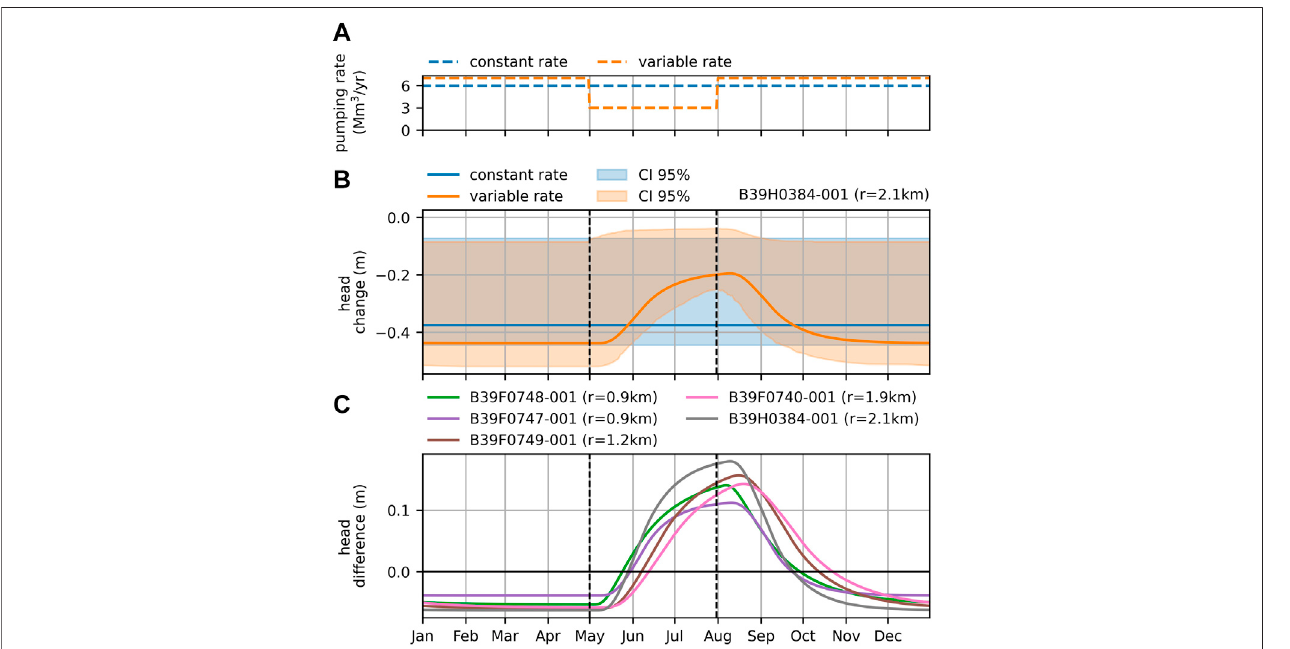
FIGURE 9 | Comparison of the effect of two pumping regimes (A) on the calculated drawdowns for well B39H0384 (B) and the differences between calculated drawdowns corresponding to different pumping regimes for all 5 phreatic models (C) . The drawdown is calculated using the derived response to pumping at well fi eld Hemmen. The shaded areas represent the 95% con fi dence